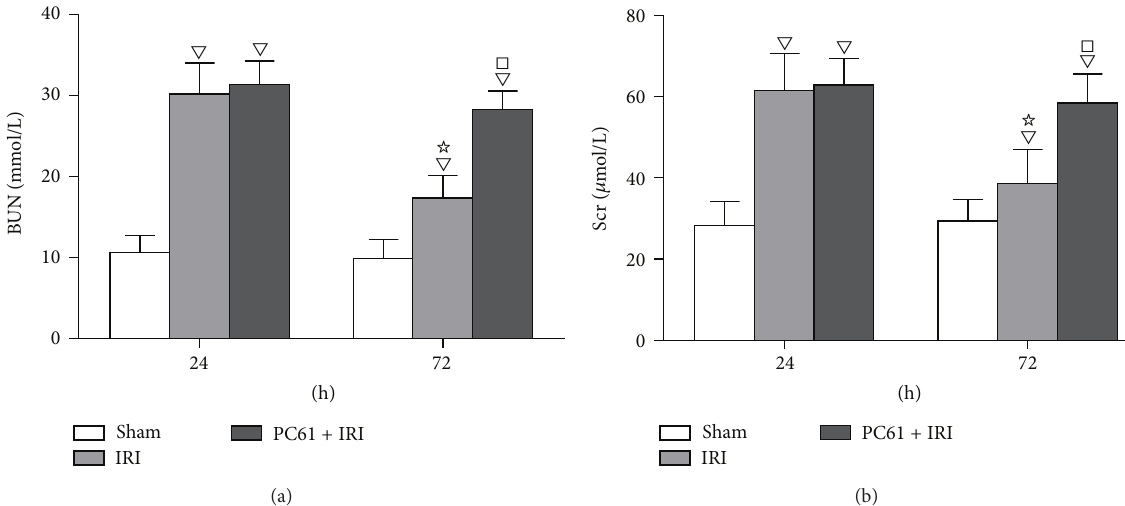
Figure 1: BUN and Scr levels at 24 h and 72 h after reperfusion. (a) Concentrations of BUN. (b) Concentrations of Scr. Values of the bar graphs represent the mean ± SD ( 𝑛 = 8 per group). Compared with the Sham group, 󳶚 𝑃 < 0.05 ; compared with the IRI group at 24 h after reperfusion, f 𝑃 < 0.05 ; compared with the IRI group at 72 h after reperfusion, ◻ 𝑃 < 0.05 .